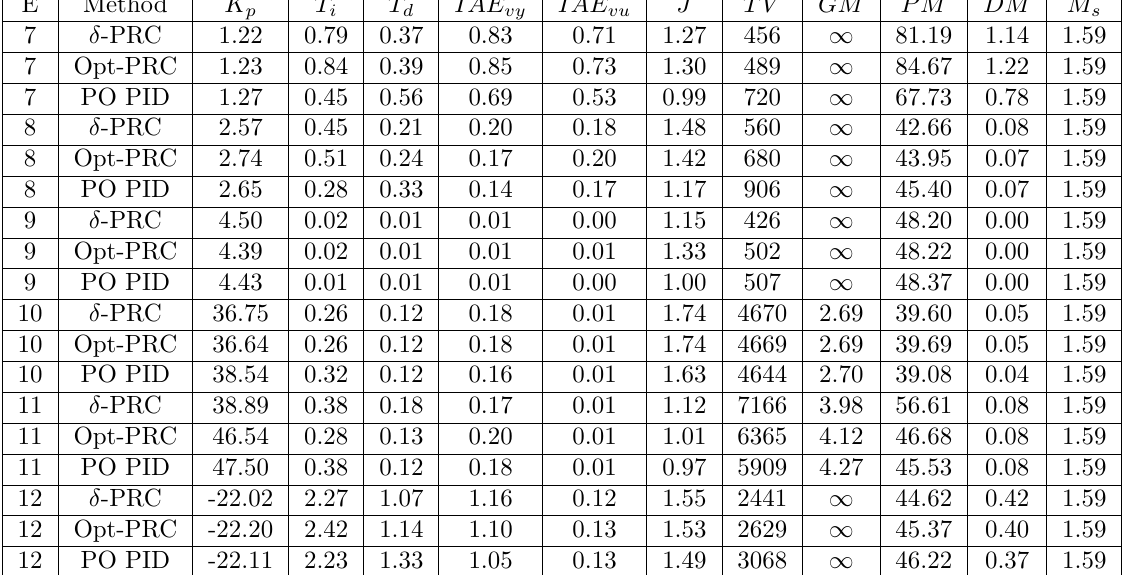
Table 7: Es7-12. The table contains the PID controller parameters for fixed robustness M s = 1 . 59 for the methods; δ -PRC, Opt-PRC and PO PID. Also include the Pareto performance J and the input usage TV . The following margins are included: Gain Margin (GM), Phase Margin (PM) and Delay Margin (DM).